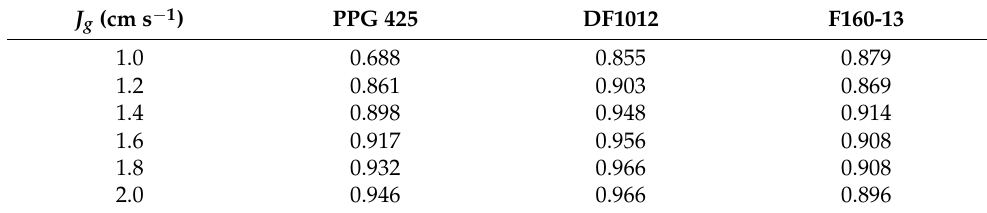
Table 5. R 2 values for the proportional trends seen in Figure